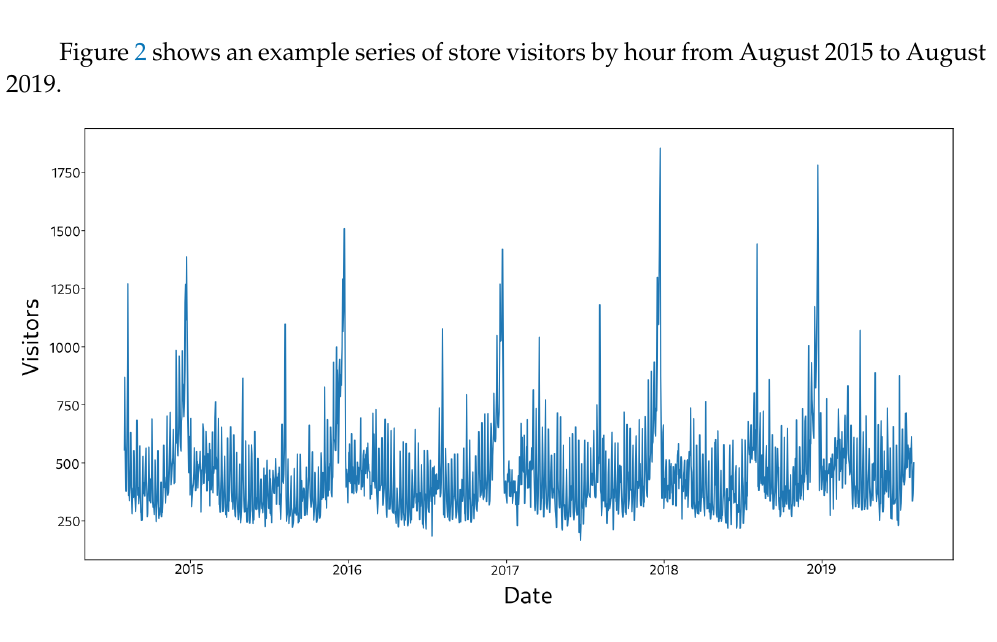
Figure 2. Store visitors by